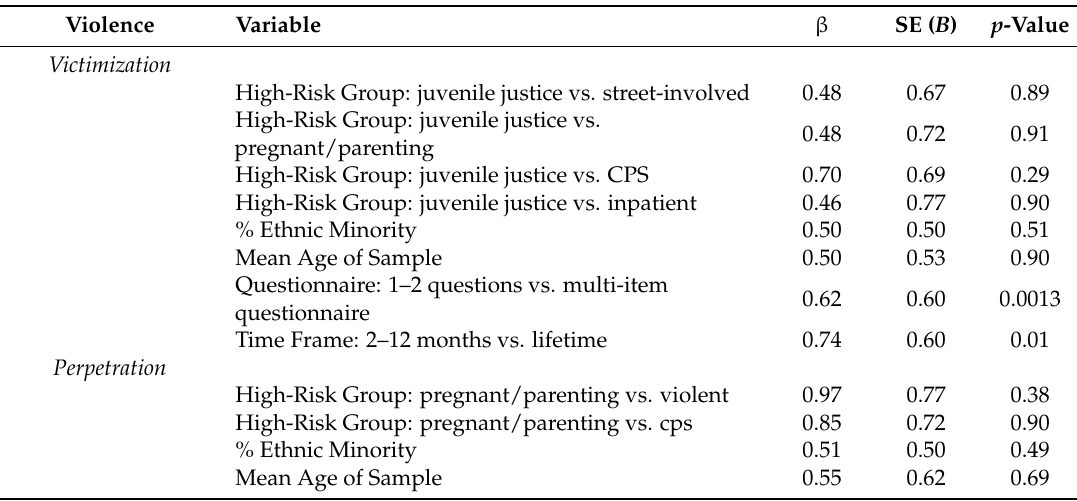
Table 4. Meta-regression